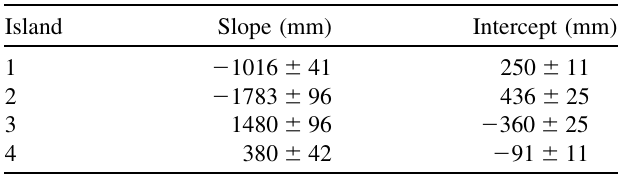
TABLE II. Linear fit results of the islands’ position (cid:5) i as a function of the fractional part of the tune from the simulation data plotted in Fig. 12.